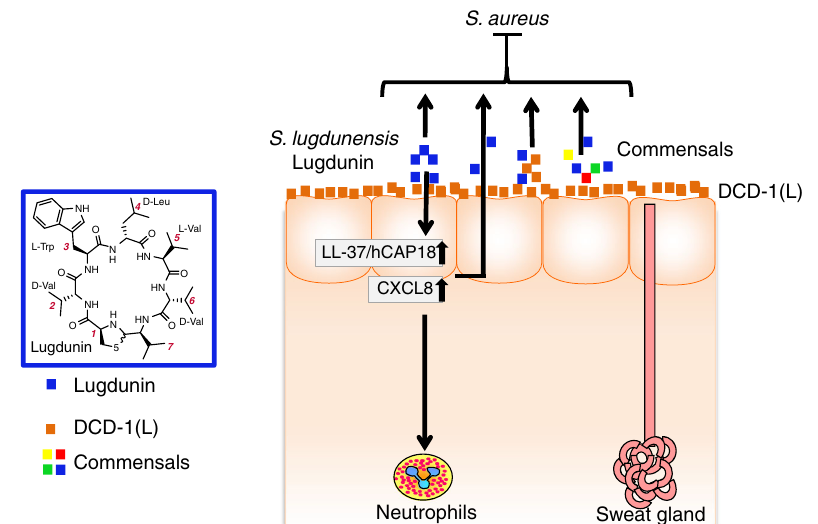
Fig. 7 Proposed model of lugdunin-mediated skin protection. Lugdunin acts on different levels to protect against S. aureus skin infection: First it can directly inhibit and kill S. aureus . Secondly, it can cooperate with host-derived antimicrobial peptides (AMPs) such as hCAP18/LL-37 and the dermcidin-derived peptides DCD-1(L) to kill S. aureus . Additionally, on a third level of protection, lugdunin induces an innate immune response of the skin, which leads to the recruitment of phagocytic immune cells, which will clear potentially invading pathogens. Finally, this innate immune response can be highly ampli fi ed by factors derived from the skin commensal S. epidermidis . Blue, lugdunin; orange, DCD-1(L); multicolored,